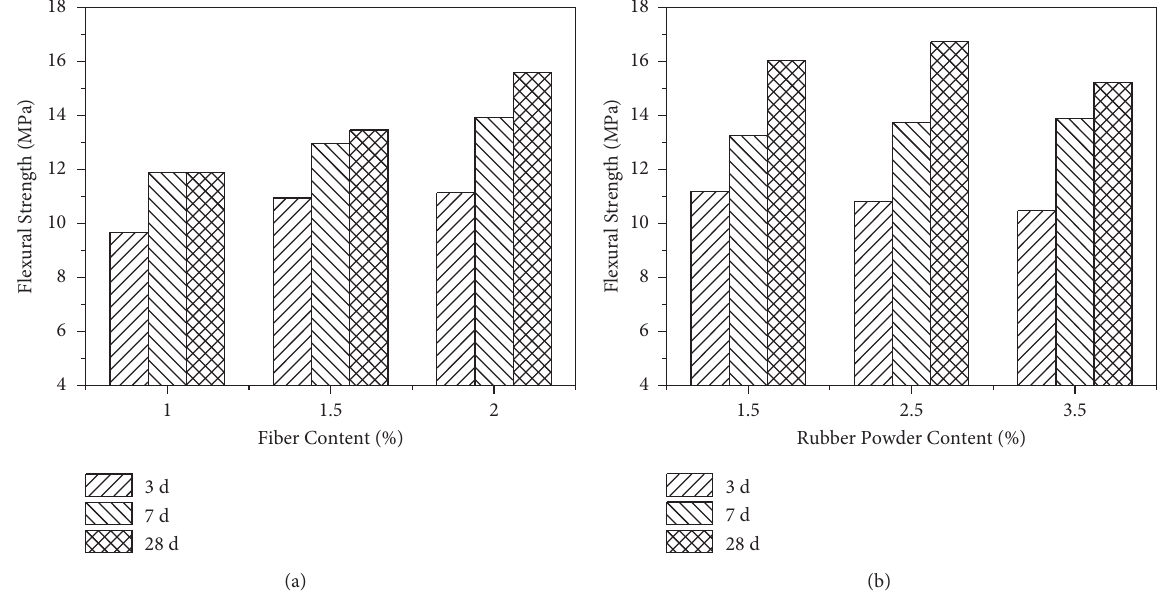
Figure 6: Flexural strength of mortar with different fiber and rubber powder contents when RH � 40%. (a) Fiber content. (b) Rubber powder content.